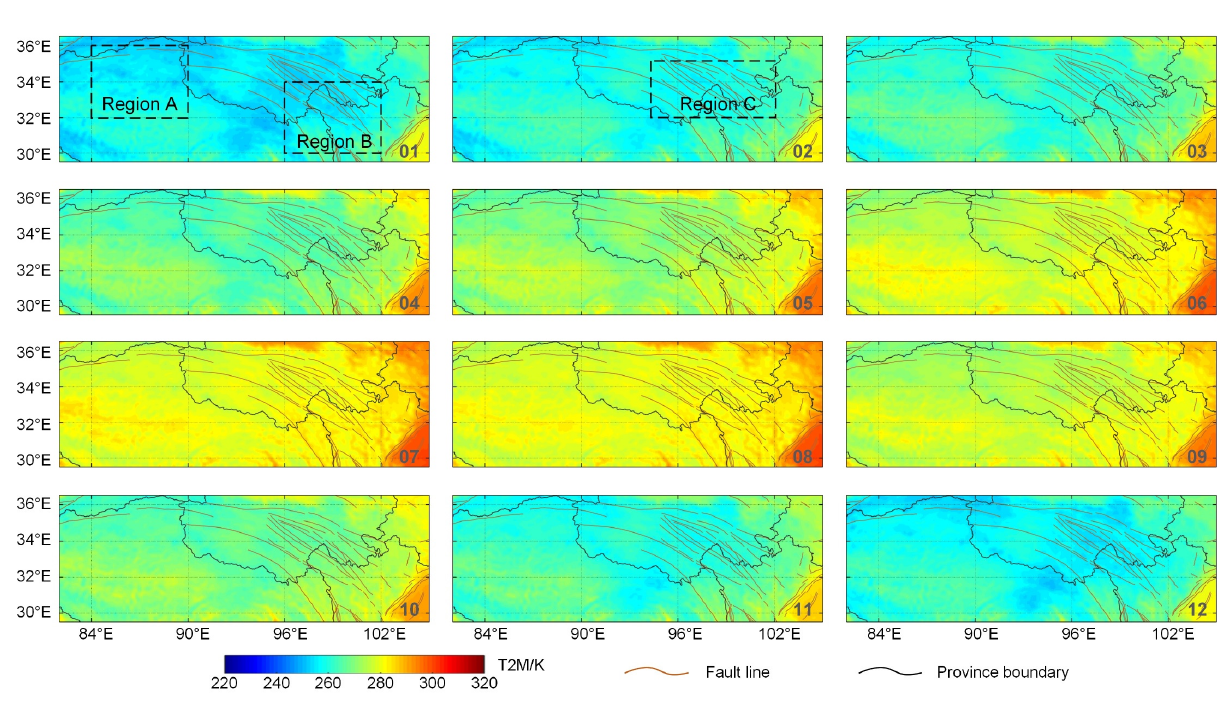
Figure A1. Monthly mean T2M in the study area.